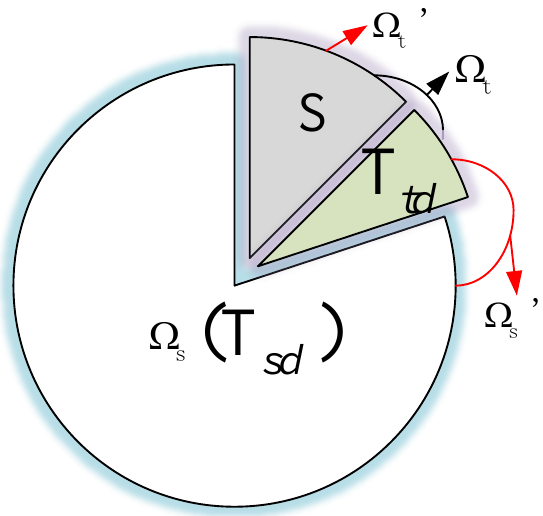
Figure 8. New training sample set in